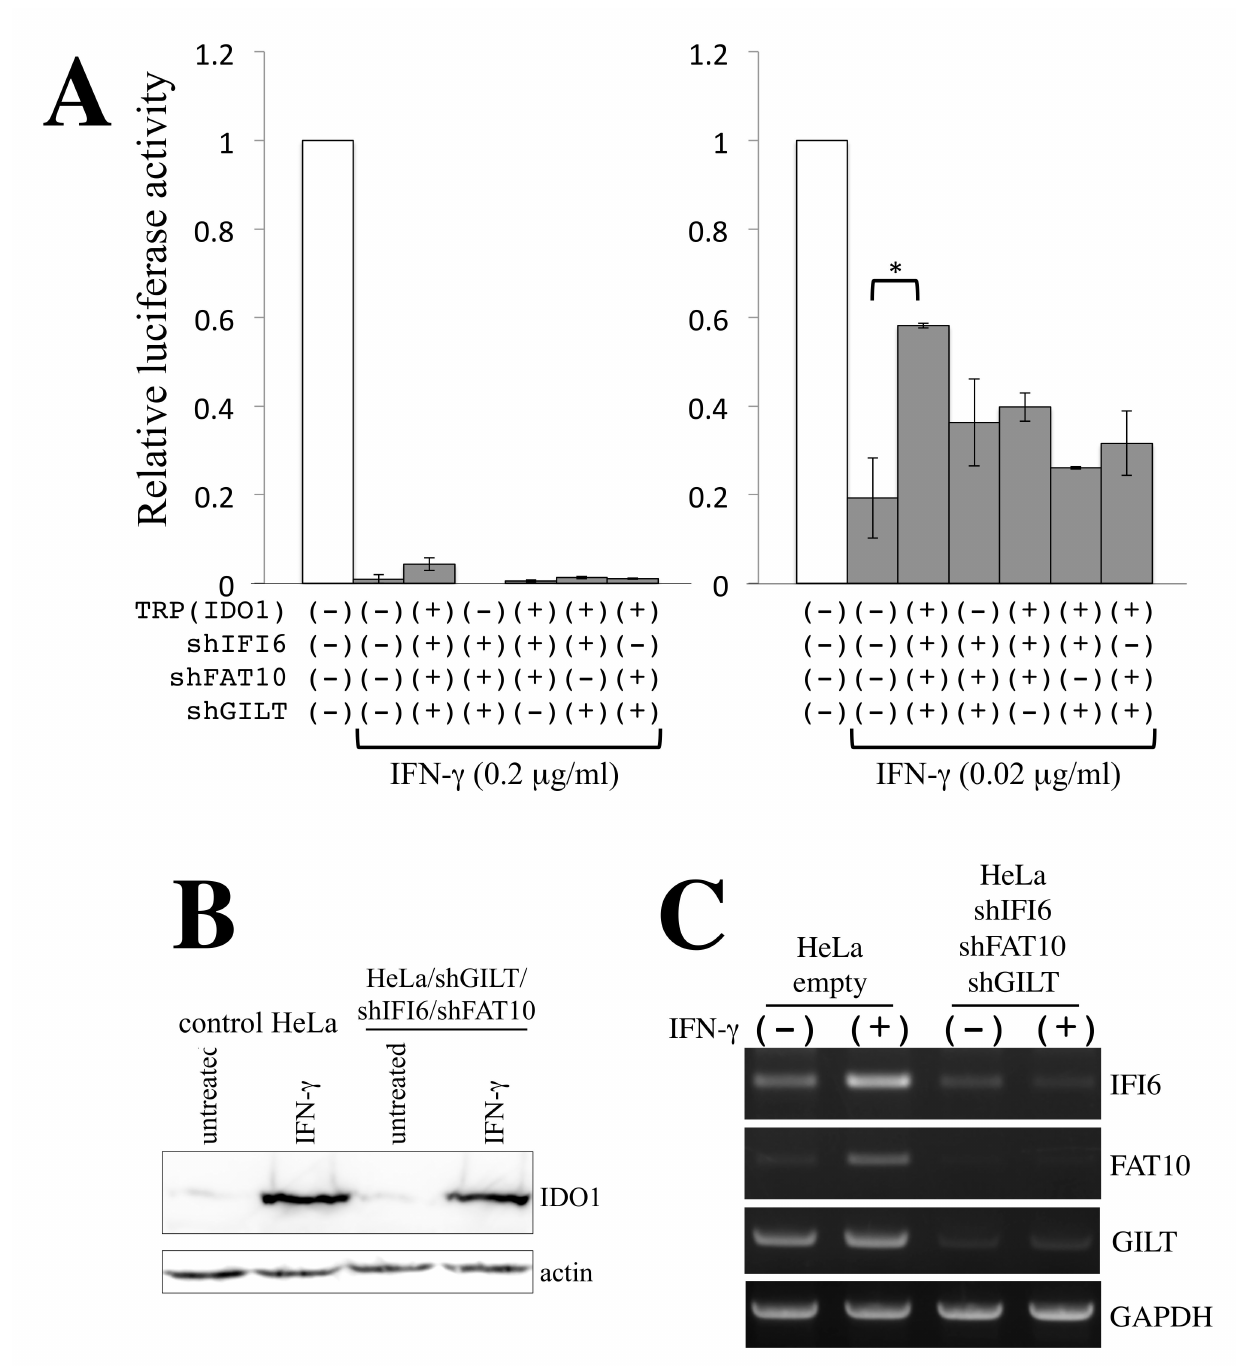
Figure 3. FAT10, IFI6, IDO1, and GILT are all involved in the antiretroviral activity of γ -IFN. ( A ) Amphotropic MLV-based vector encoding Renilla luciferase was inoculated to the indicated cells in the absence or presence of γ -IFN. Luciferase activities in control HeLa cells without γ -IFN are always set to 1, and relative values ± SD are indicated. Asterisks indicate significant differences between the indicated groups. This experiment was performed in triplicate. ( B ) Cell lysates were prepared from indicated cells untreated and treated with γ -IFN and were analyzed by Western blotting. ( C ) Total RNA samples were prepared from the indicated cells in the absence or presence of γ -IFN. Levels of IFI6, FAT10, GILT, and GAPDH were measured by semi-quantitative